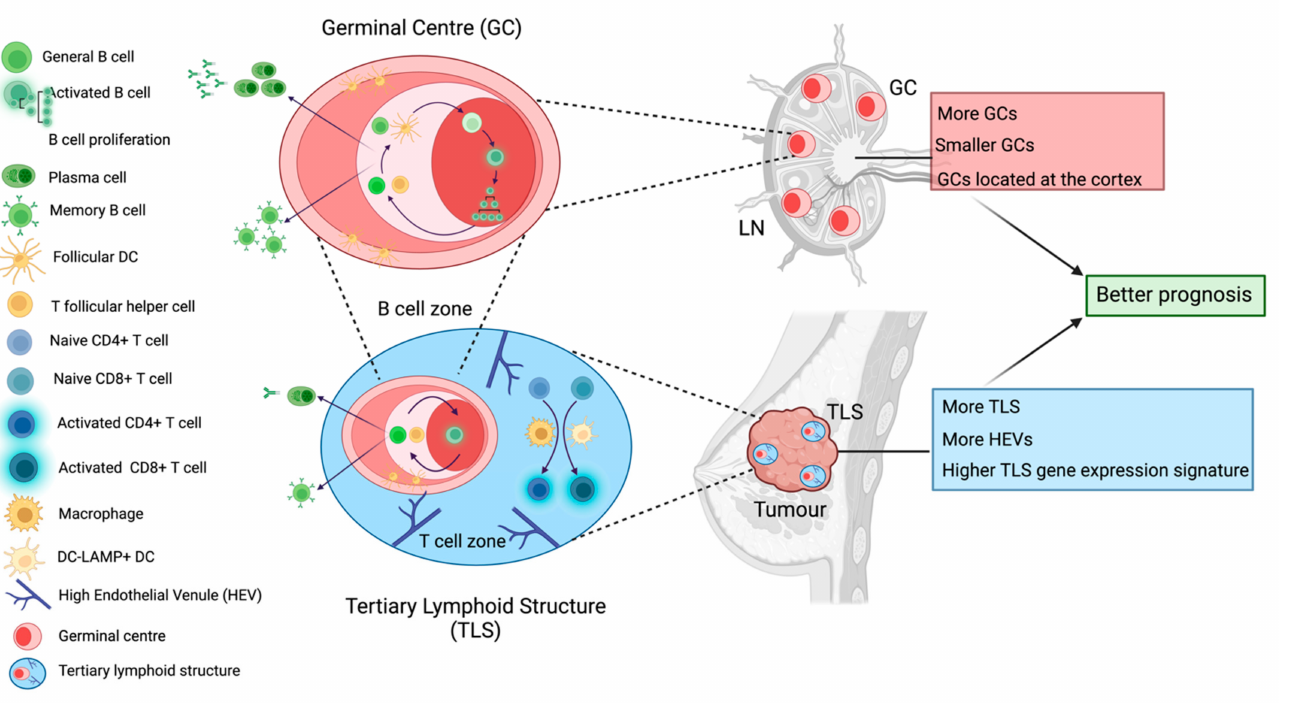
Figure 2. Tertiary lymphoid structures and germinal centres within the lymph node. Both tertiary lymphoid structures (TLSs) and germinal centres hold cellular and functional similarities which are associated with better prognosis in breast cancer patients. Germinal centres are dynamic immune structures within LNs which lead to the generation of affinity matured antibody-producing cells and memory B cells via strong interactions between activated B cells and T follicular helper (Tfh) cells as well as follicular dendritic cells (FDCs). The germinal centre is organised into two zones: the light zone where these intercellular interactions occur and the dark zone where selected B cells